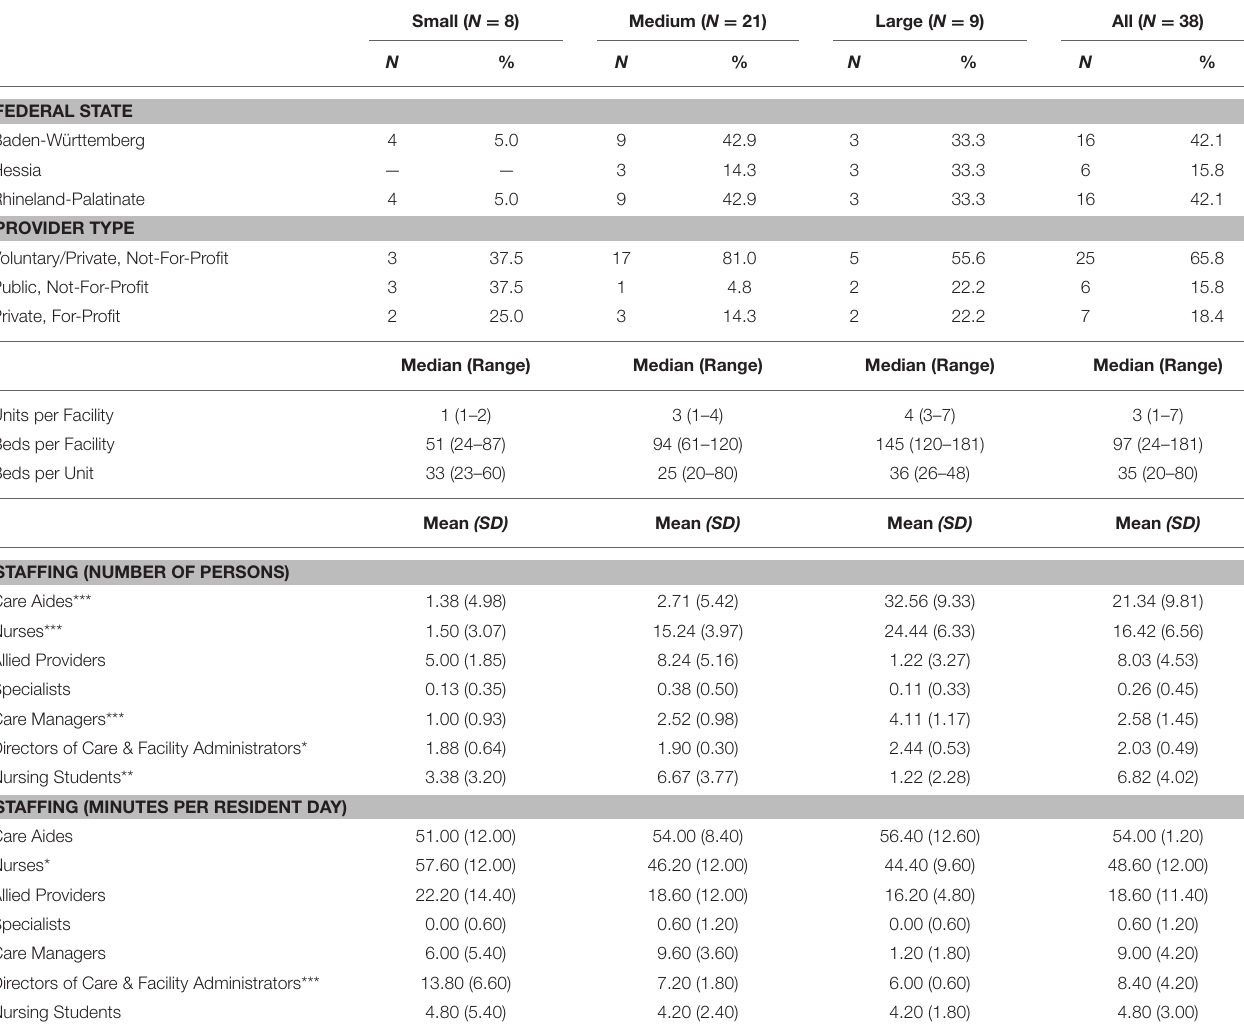
TABLE 6 | Characteristics of the participating